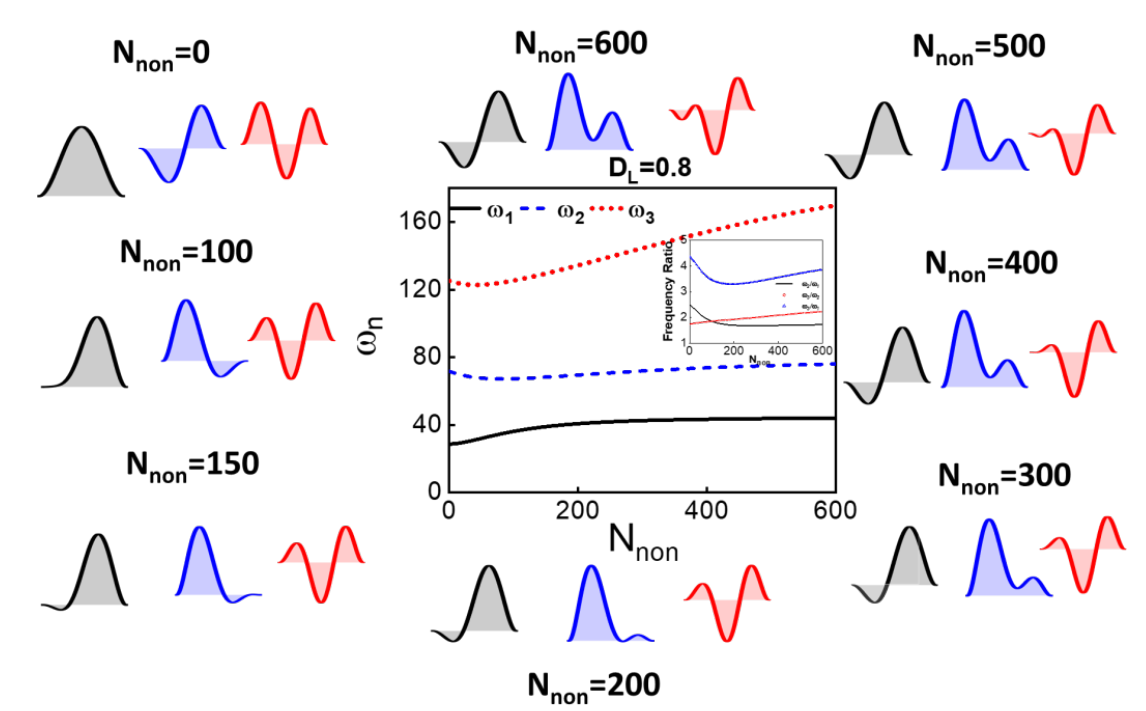
Figure 7. ( a , b ): The variation of the three lowest natural frequencies with axial load for different dome lengths, D L = 0.5 and D L = 0.8, respectively. The initial rise of the dome is equal to 2 μ m. ( a , b ) shows the mode shapes associated with the three lowest natural frequencies at different axial loads.